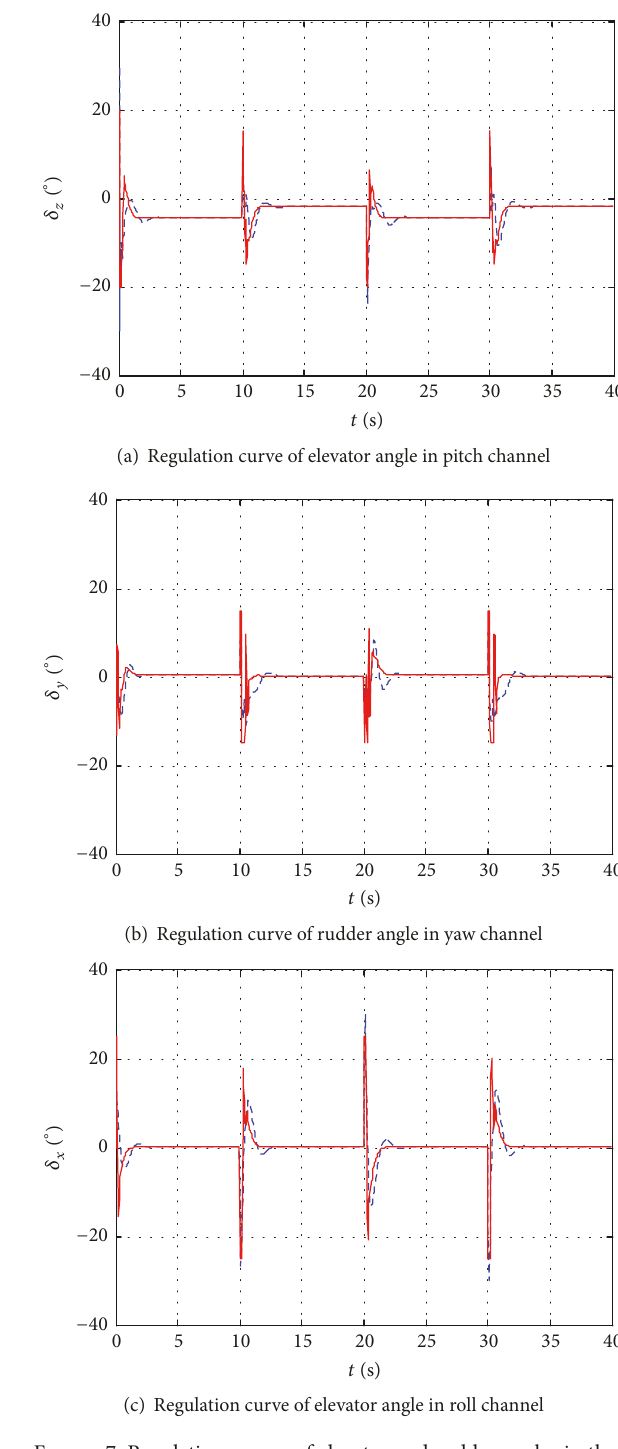
Figure 6: Regulation curves of angular velocities. Figure 7: Regulation curves of elevator and rudder angles in three